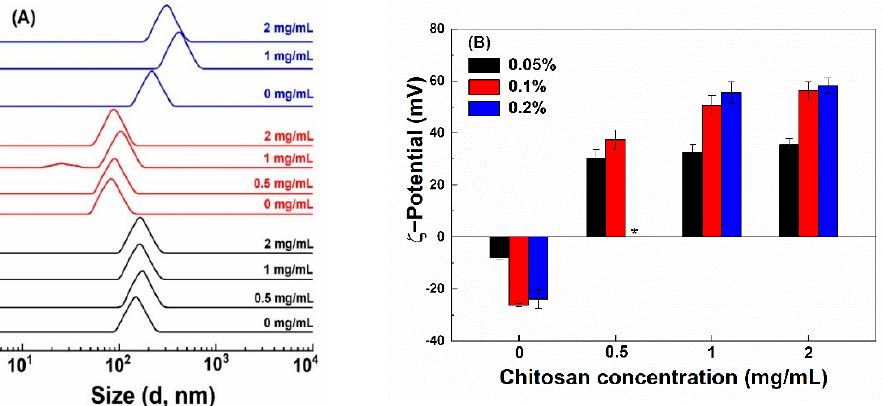
Figure 1. Particle size distribution ( A ) and ζ − potential ( B ) of hollow zein particles fabricated with 0.5% (black), 1% (red) and 2% (blue) Na2CO3 and coated with chitosan at various concentrations (Mark at the right). * indicates unstable particles.